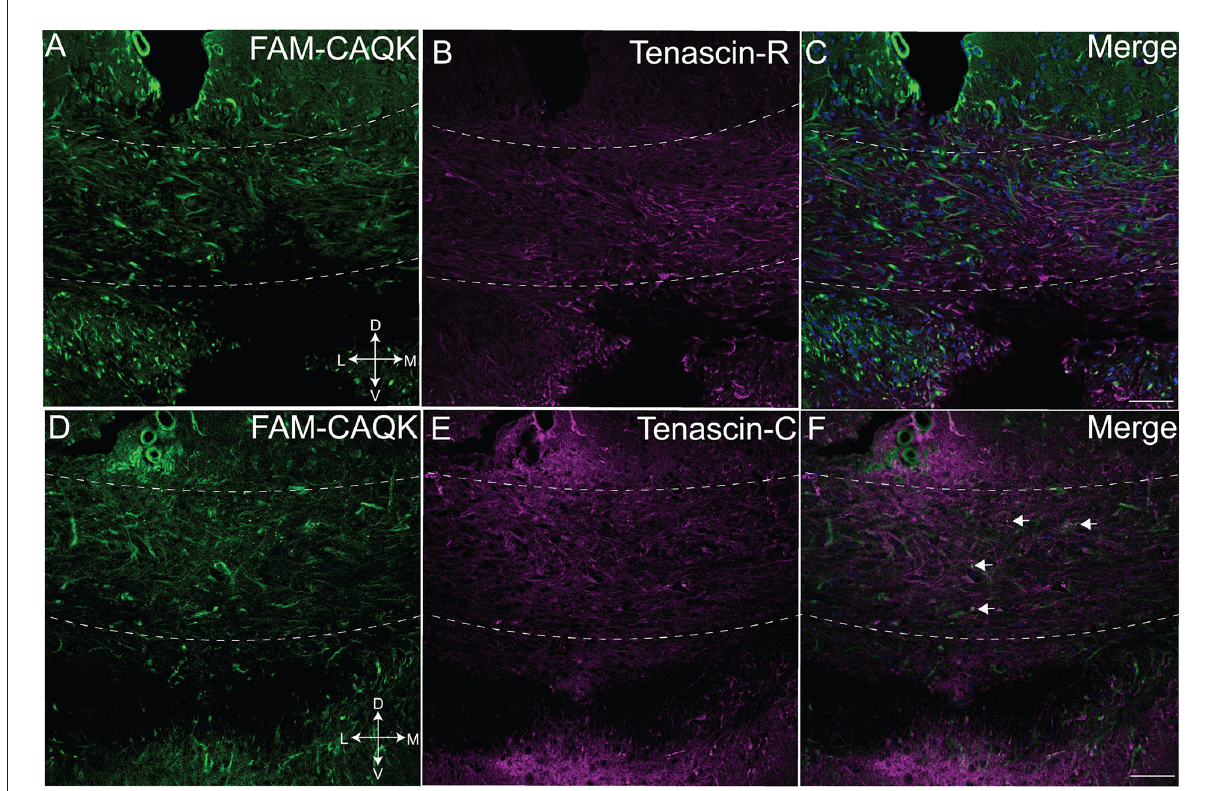
FIGURE4 Marginal CAQK peptide association with tenascins in the cuprizone model. Confocal images from the demyelinating corpus callosum of mice on a 6-week cuprizone diet show FAM-CAQK peptide ( A,C , green) in complementary distribution with tenascin-R ( B , magenta); merged images in (C) . FAM-CAQK peptide (D) shows marginal association (white puncta pointed out by arrows in F ) with tenascin-C ( E magenta). DAPI-staining (blue) indicates cell nuclei in (C,F) . D, dorsal; V, ventral; L, lateral; M, medial. Scale bar = 50 µ